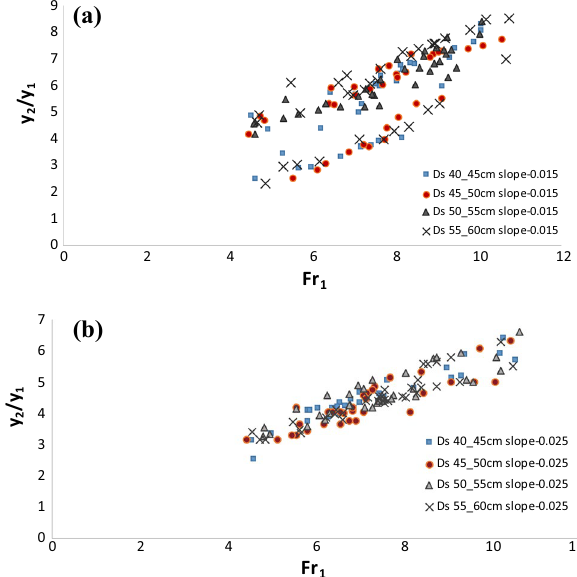
Fig. 3 Sequent depth ratio y double screens with different distances a S 0 = 0.015 b S 0 = 0.025)